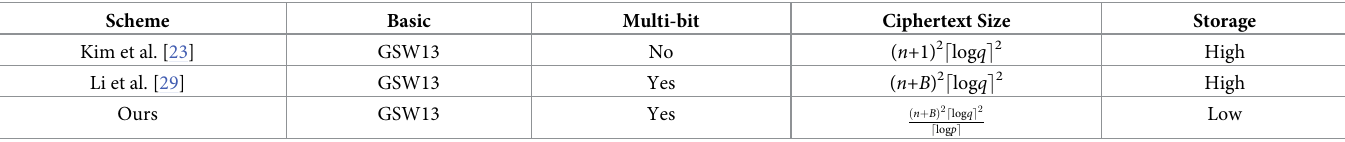
Table 1. Performance comparison of schemes without